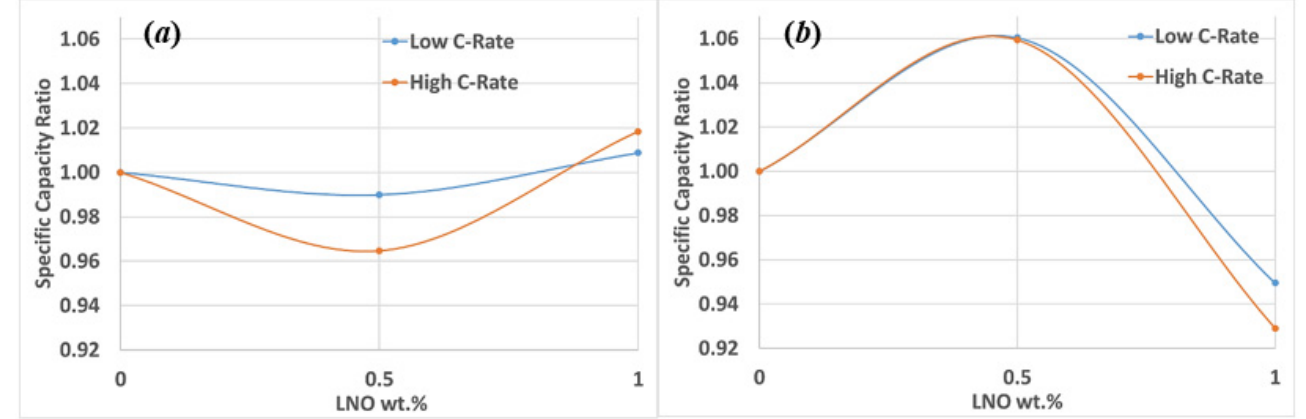
Figure 12. Specific capacity ratio of the coated-NMC-60 for ( a ) Method-I, and ( b ) Method-II for low or high c-rates of C/10 and 2C.